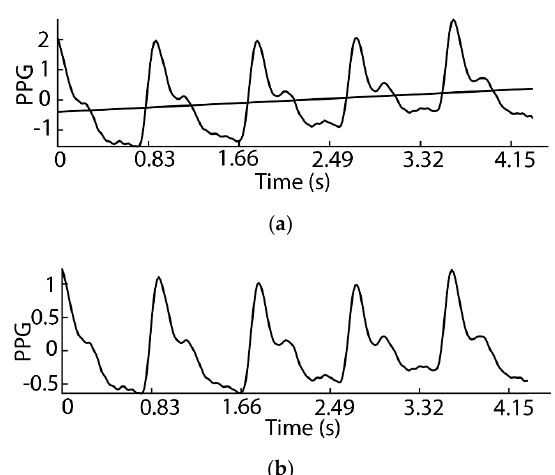
Figure 7. Filtered signal in SPW.